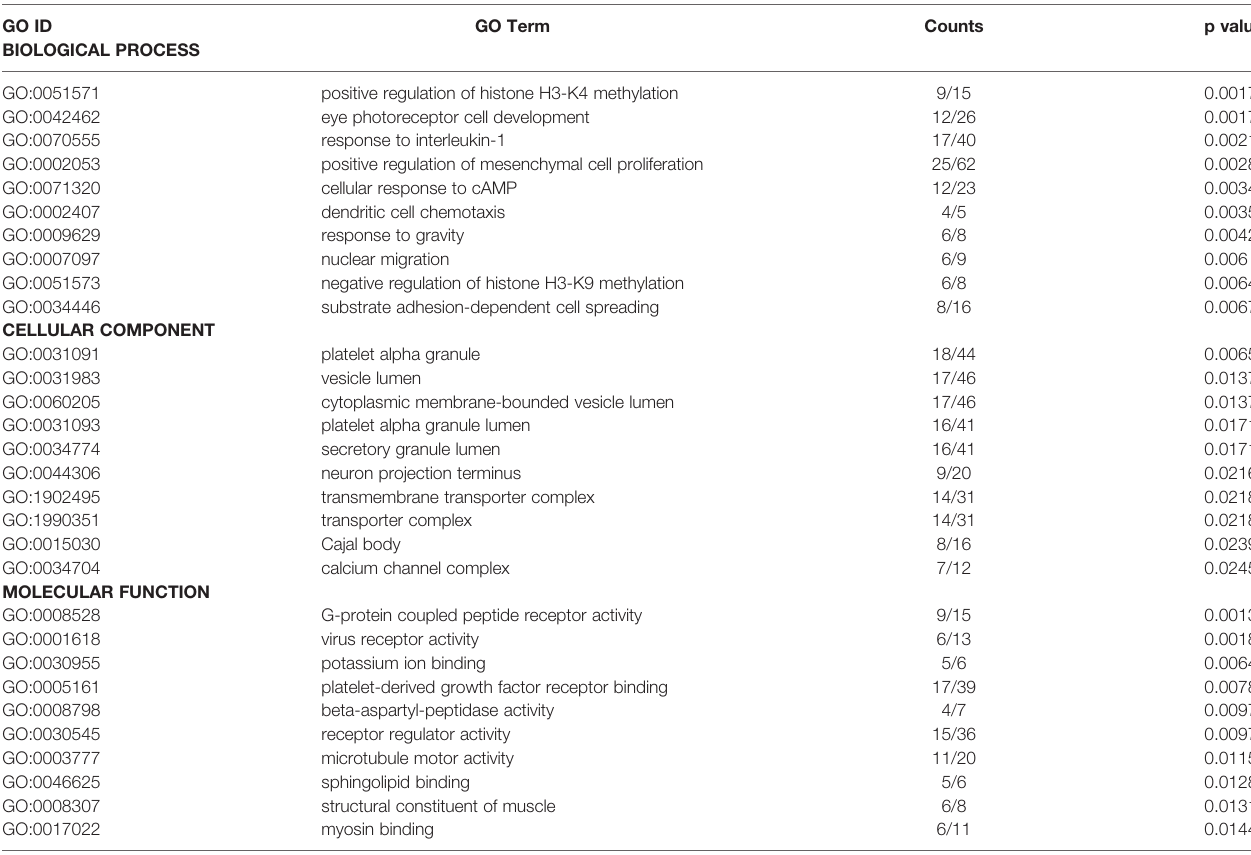
TABLE 3 | Gene Ontology (GO)